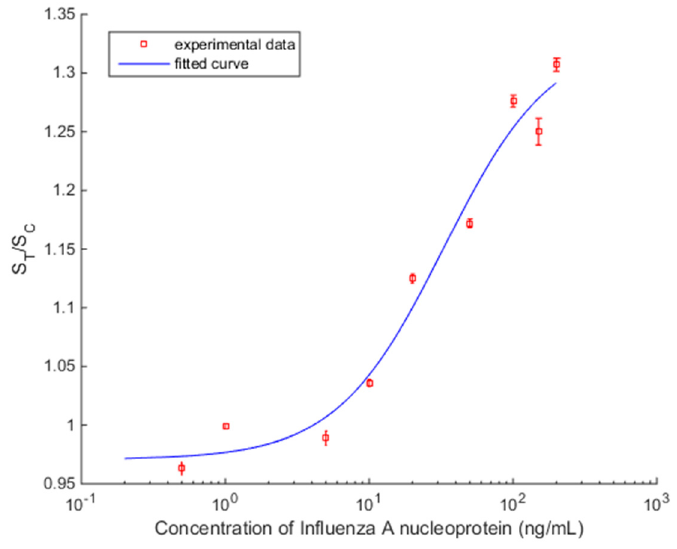
Figure 10. The fitted curve of S T /S C for various concentrations of Influenza A nucleoprotein based on the 4PL model. The error bars indicate the ±2 σ limits.